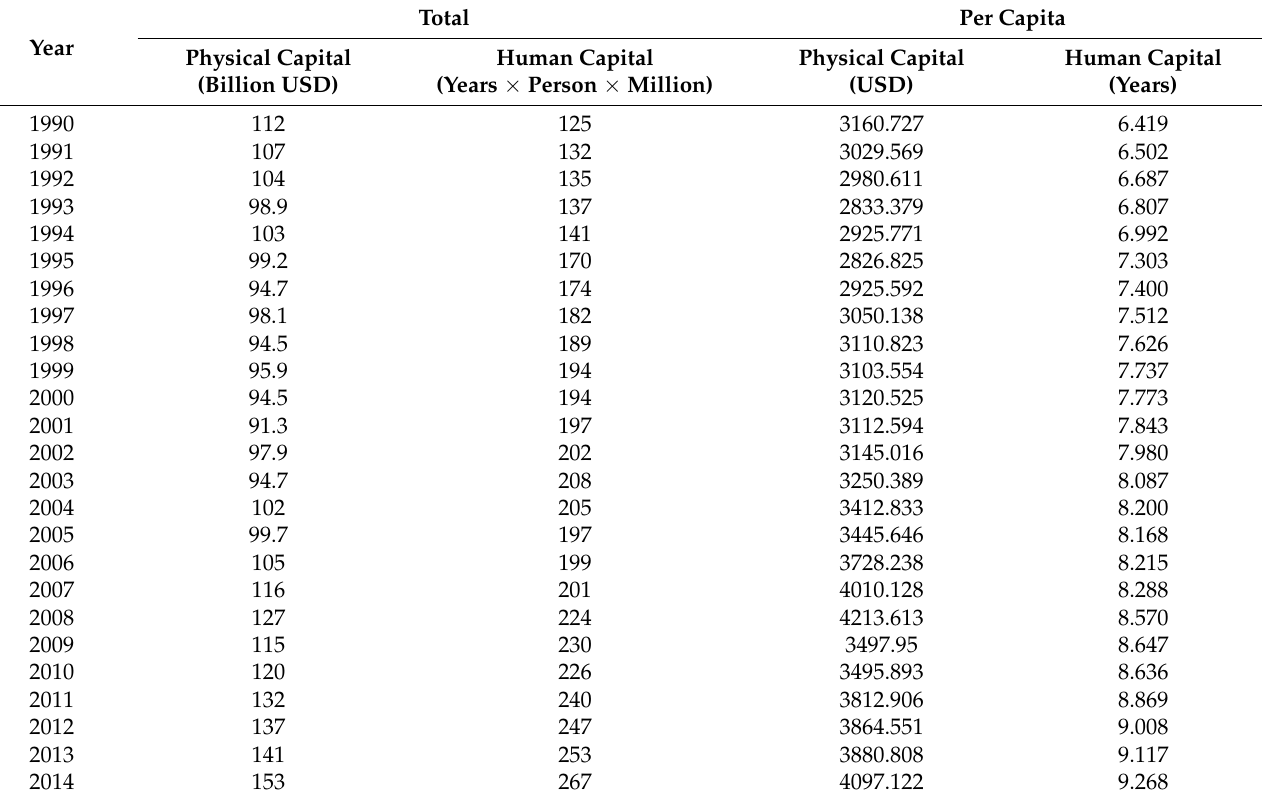
Table 1. Stocks of physical and human capital over the period